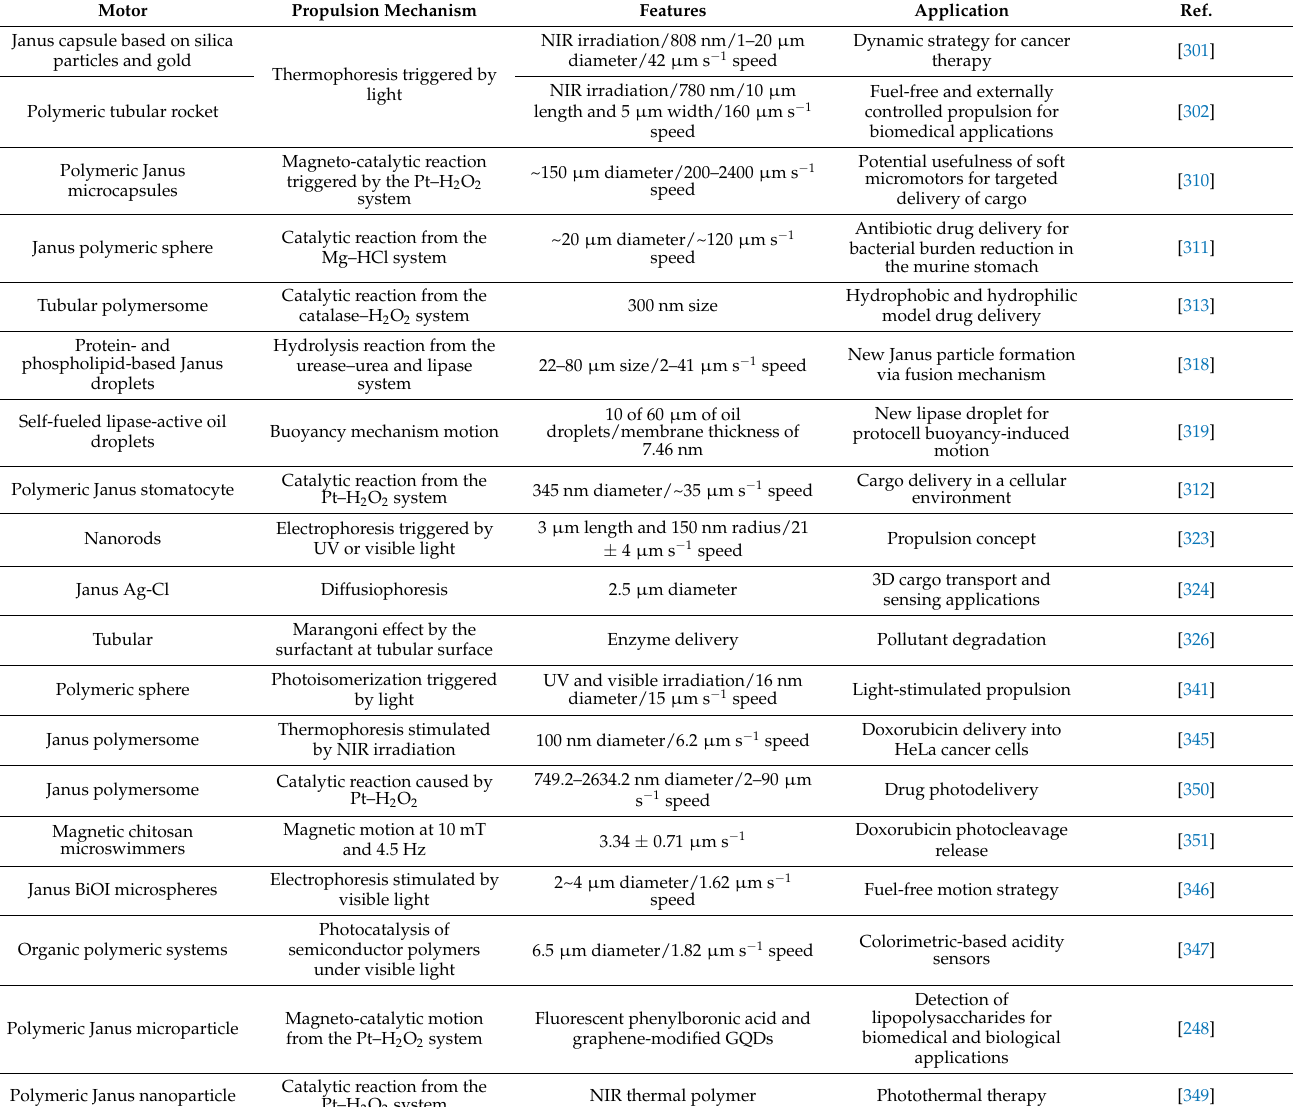
Table 4. Propulsion mechanisms, features and applications of